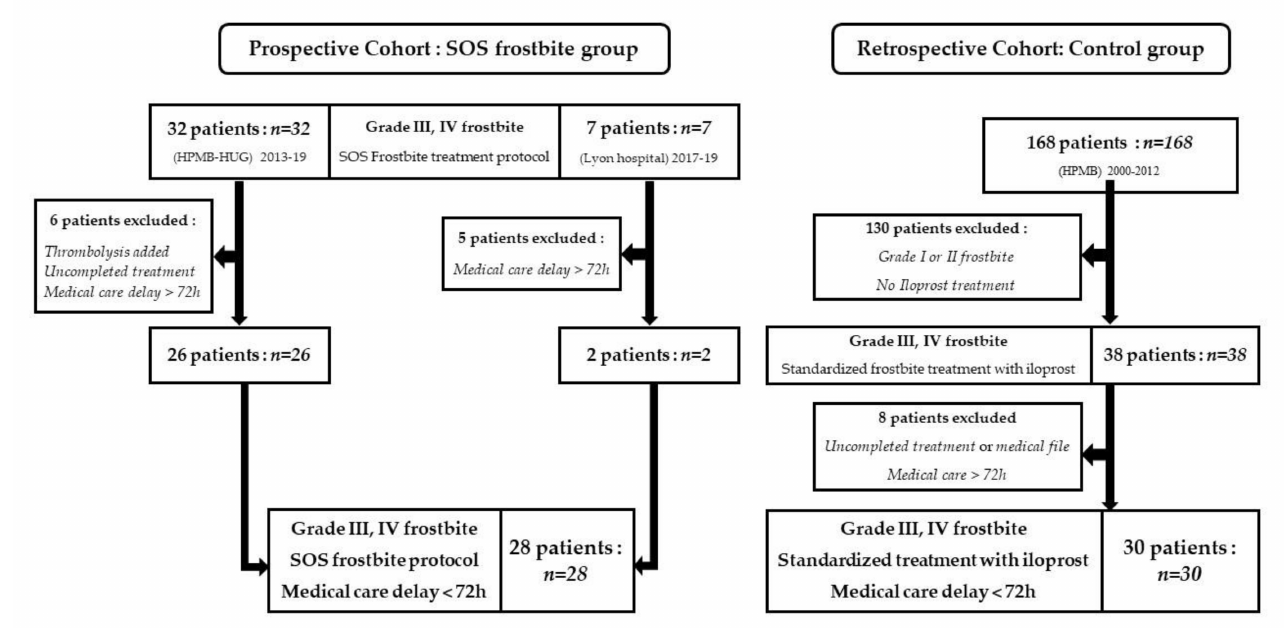
Figure 2. Study flow